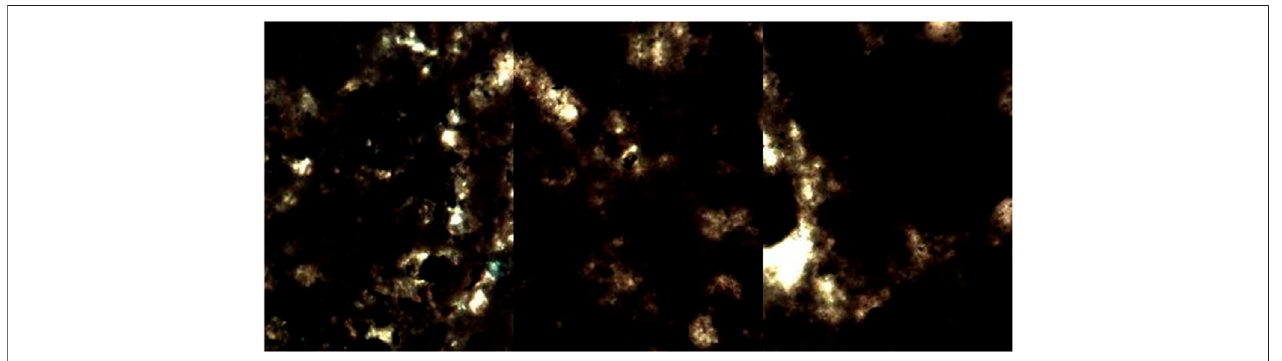
FIGURE 5 | Microscopic morphology of PEM drilling fl uid treated with organic fl